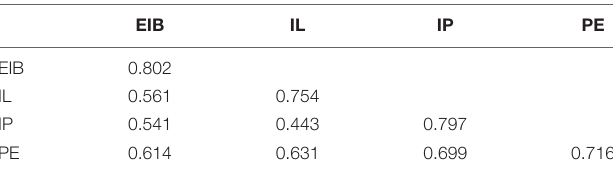
TABLE 3 | Fornell–Larcker